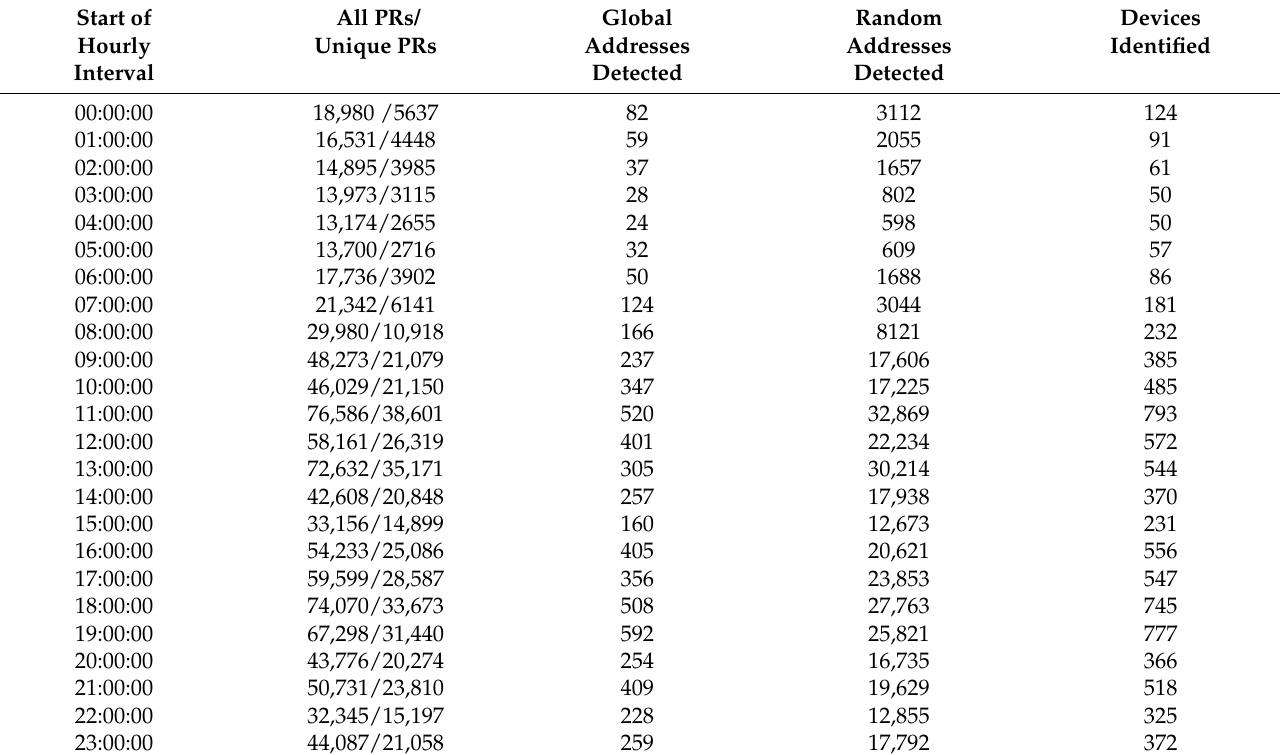
Table 8. MAC de-randomization results for one day at Piazza del Duomo,